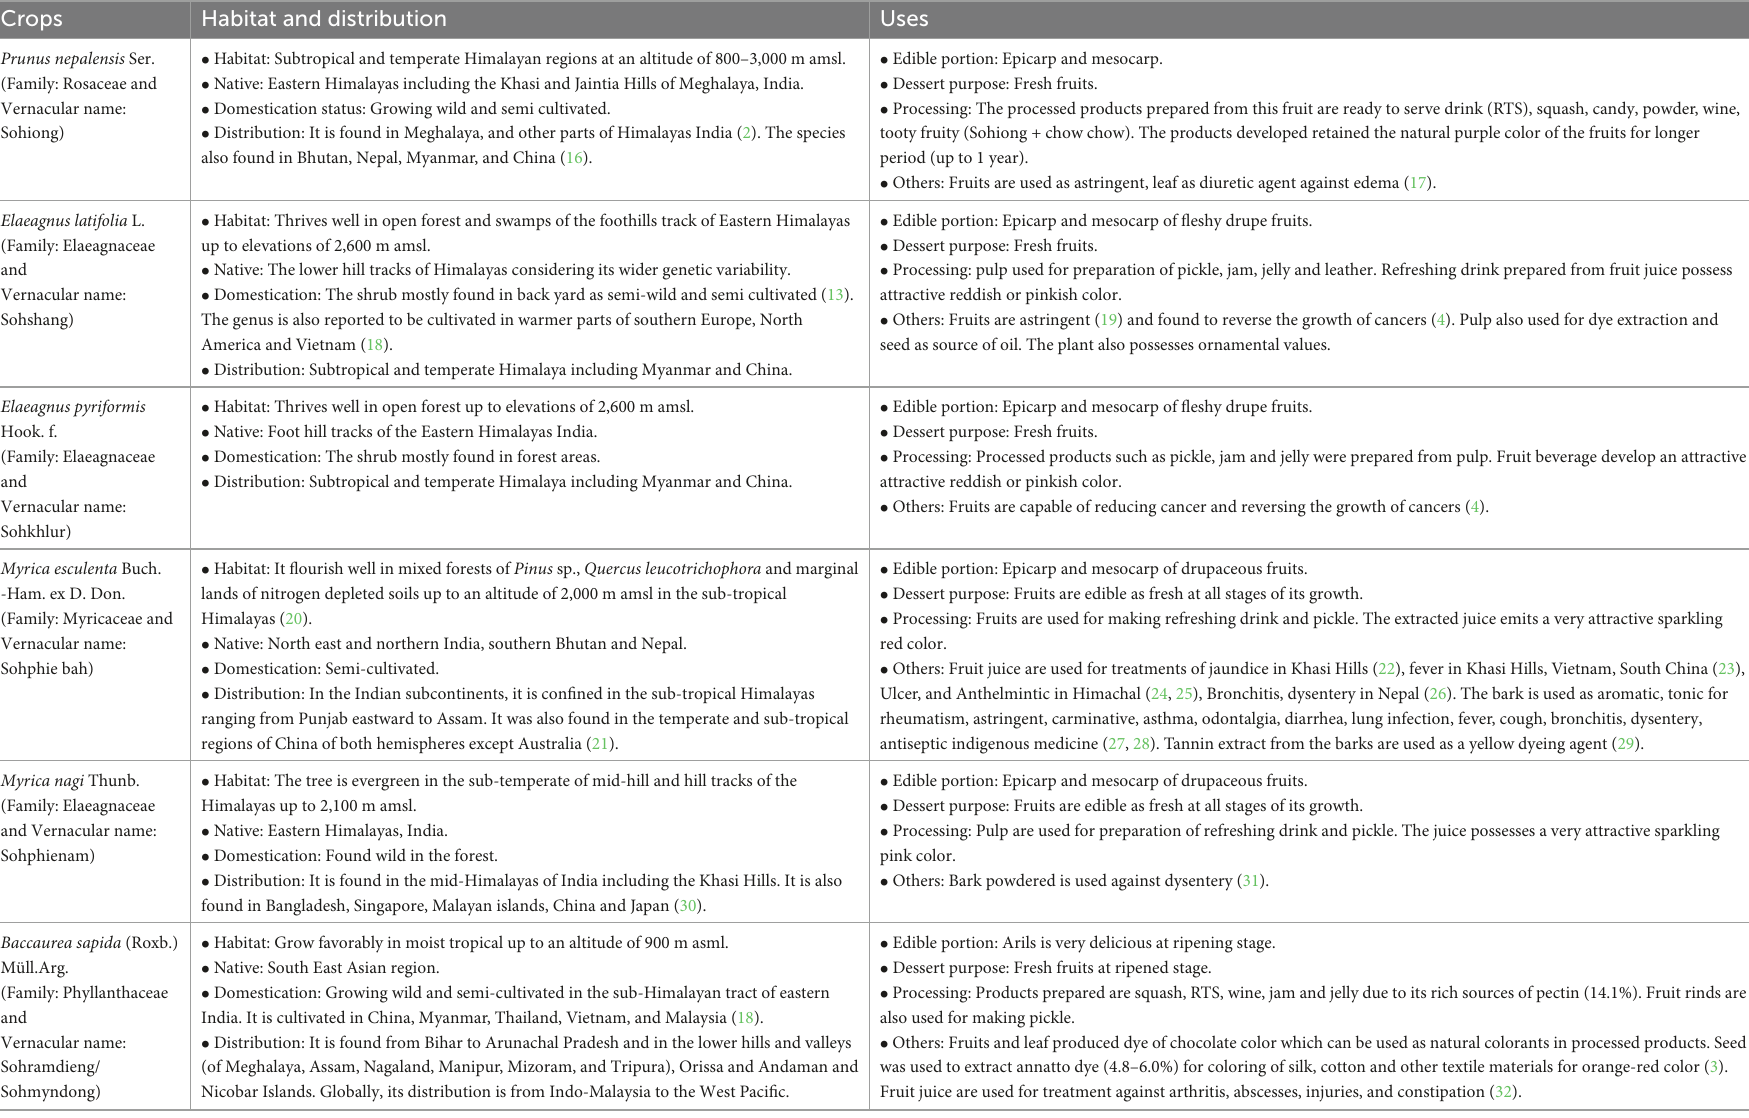
TABLE 1 Habitat, distribution, and utilization of wild edible fruit crops of the eastern Himalayas, India. Crops Habitat and distribution Uses Prunus nepalensis Ser. (Family: Rosaceae